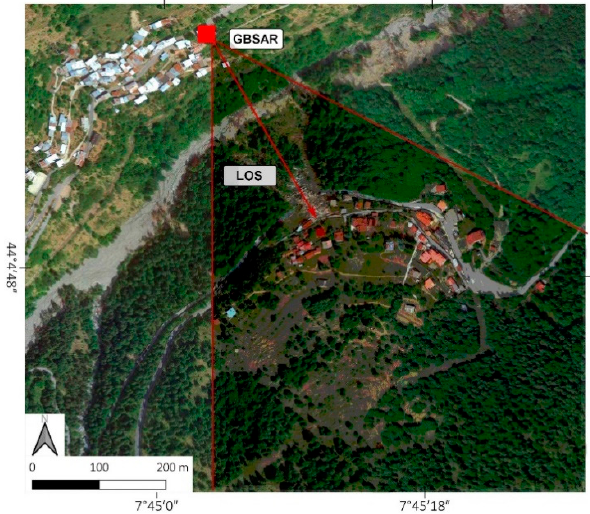
Figure 11. Aerial view of the area of the Monesi di Mendatica landslide with the radar location, LOS direction, and rough extension of the radar FOV indicated.